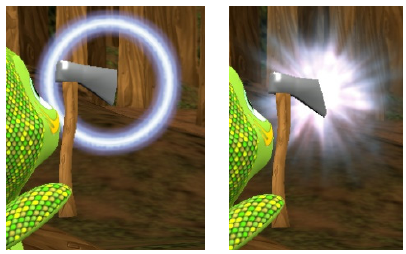
Fig. 7: Details of “Chop the wood”. Left: the axe is charging, right: it is ready to use.